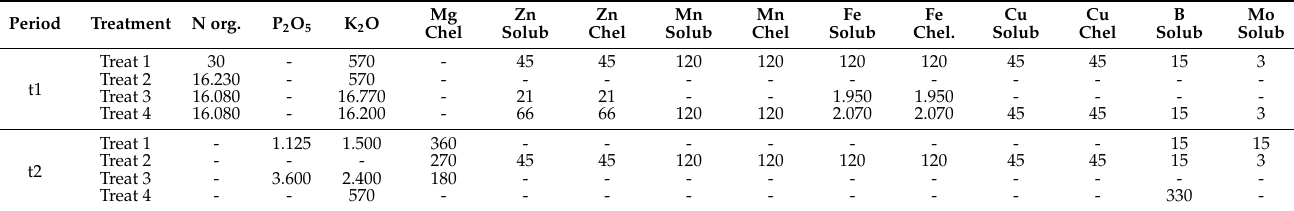
Table 1. Total macro and microelements (g/ha) included in each nutrient mixture per period and treatment. For each period (t1 and t2), three treatments were carried